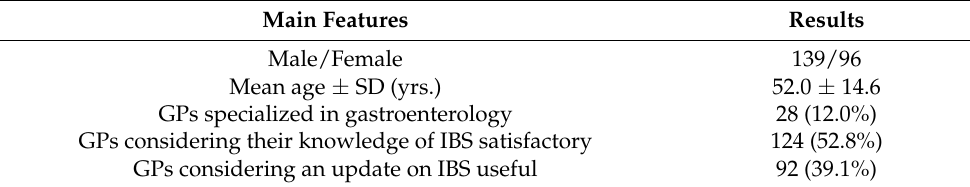
Table 2. Main features of the 235 GPs who participated in the study.